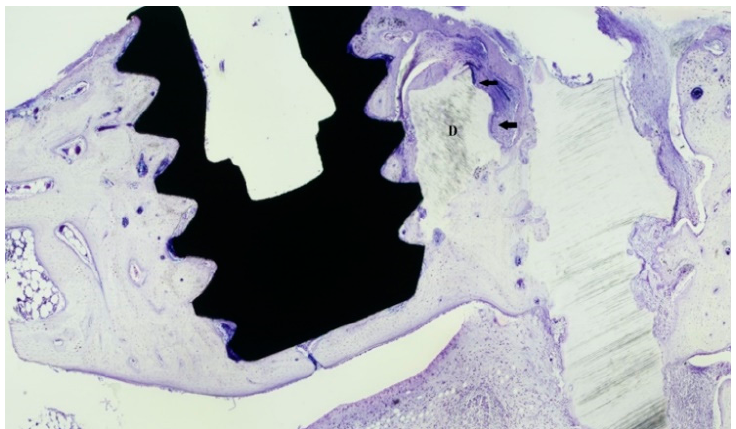
Figure 5. Histological specimen demonstrating a dentin block ( D ) that is fused to the surrounding bone and exhibiting external resorption (arrows). Fragmentary contact between the dentin and titanium surface can be noted. Toluidine blue stain; 10× magnification.